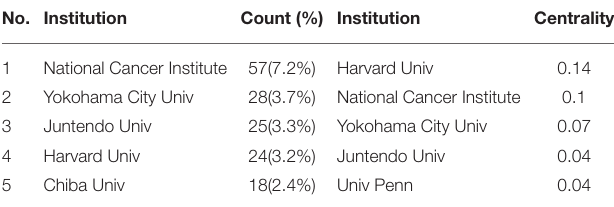
TABLE 3 | The top 5 institutions for publications and centrality in BHD